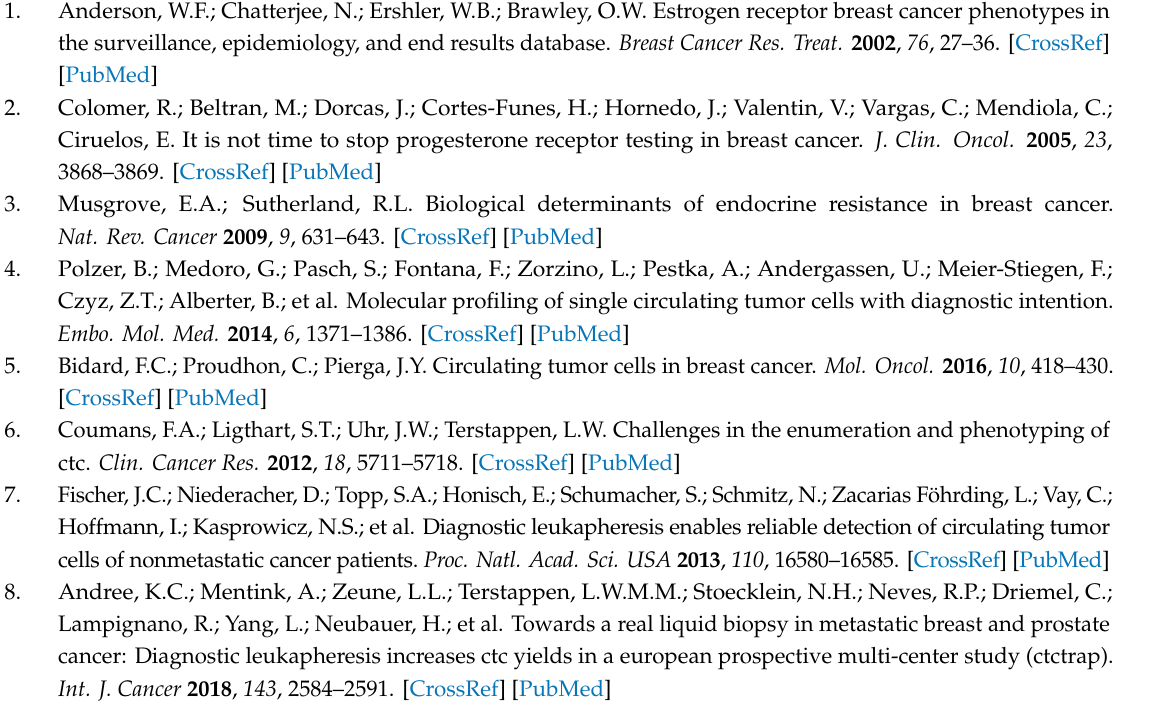
Table S1: Gene panel, Figure S1: Single cell analytics, Figure S2: Combined gene expression analysis of single uncultured and cultured